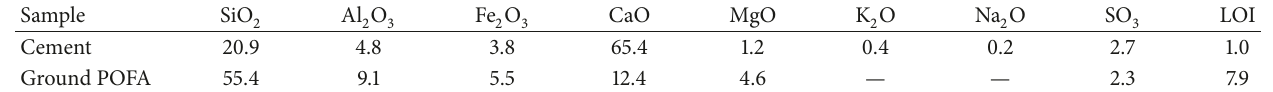
Table 2: Chemical composition s of the ground POFA and Type I Portland cement.